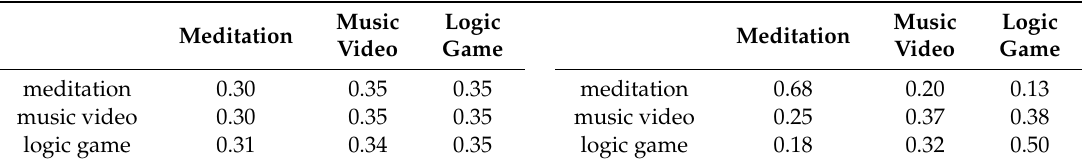
Table 12. Normalized confusion matrix for SVM classifier with linear kernel, value of C = 0.01, and dwt feature extraction scheme (left). Normalized confusion matrix for SVM classifier with linear kernel, value of C = 0.01, and dwt_stat feature extraction scheme (right).